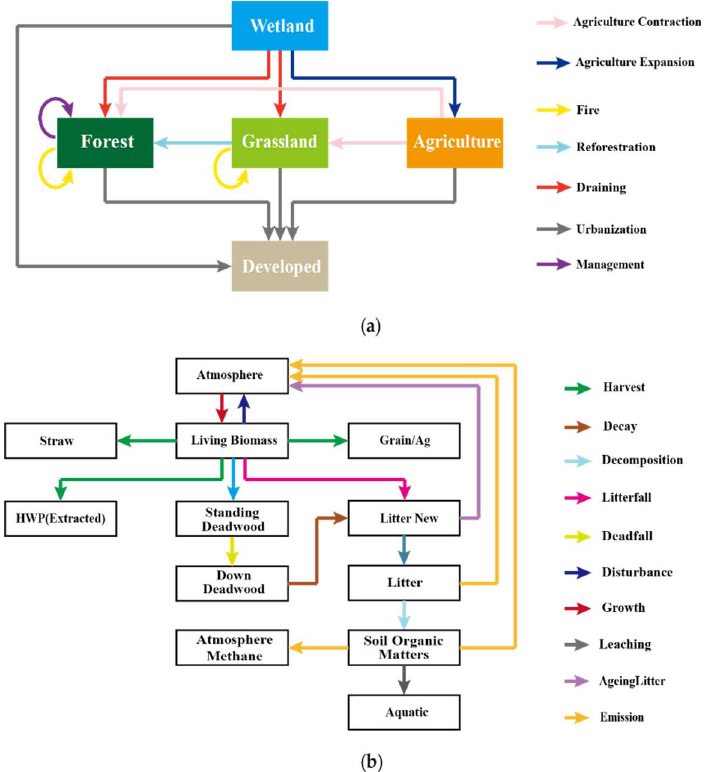
Figure 2. Flowchart showing carbon stocks (boxes) and flows (arrows) for terrestrial carbon budget model. Pathway diagrams for state-and-transition simulation model with stock and flows. ( a ) Transition diagram showing state types and transitions (arrows) for land-use/land-cover change model. ( b ) Flow diagram showing stocks (boxes) and flows (arrows) for terrestrial carbon budget model.